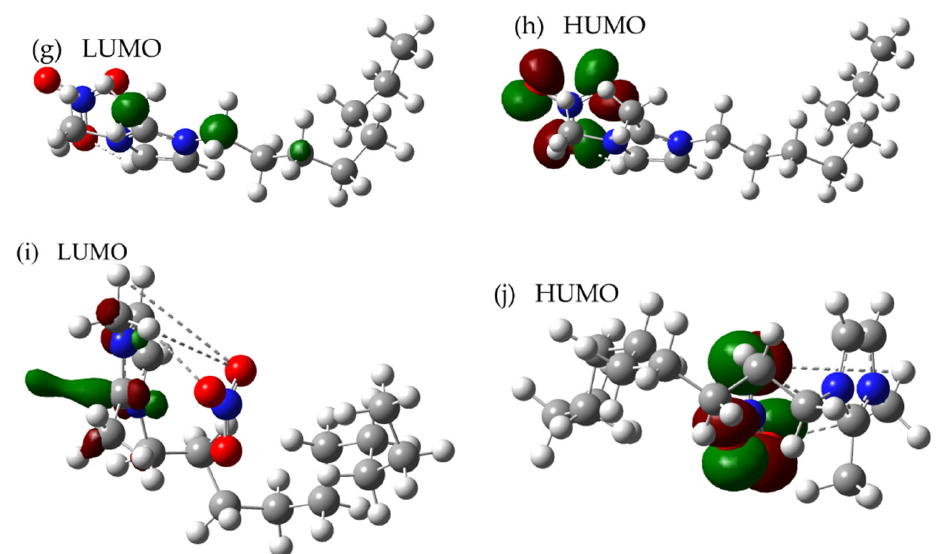
Figure 8. The results of the frontier molecular orbital for [Emmim][NO 3 ] ( a , b ), [Bmmim][NO 3 ] ( c , d ), [Hmmim][NO 3 ] ( e , f ),